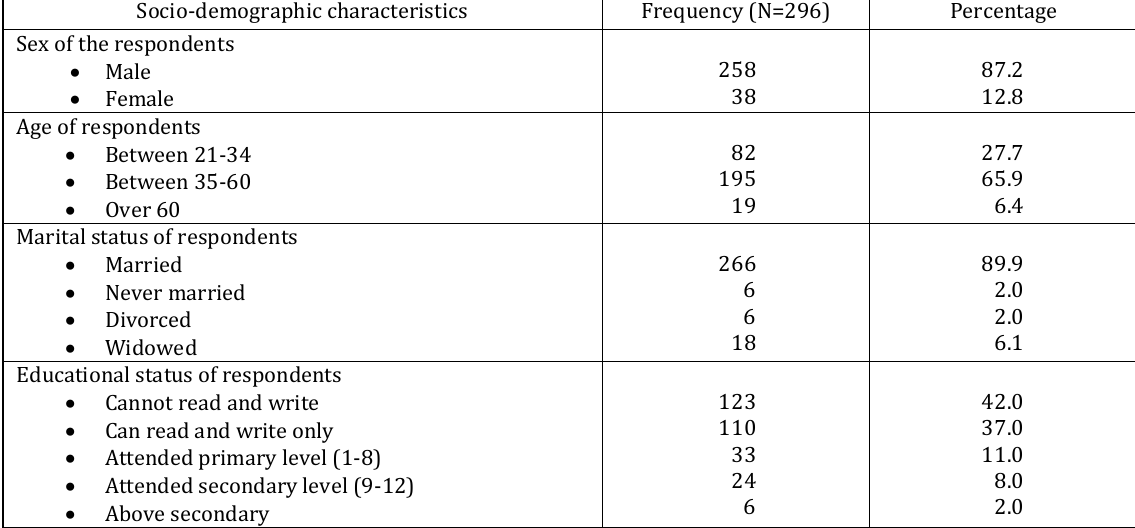
Table 1. Demographic characteristics of the respondents (Source: Survey, April 2018) Socio-demographic